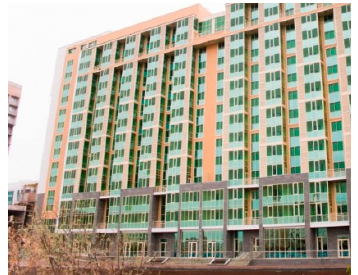
Figure 3. Comfort class building.